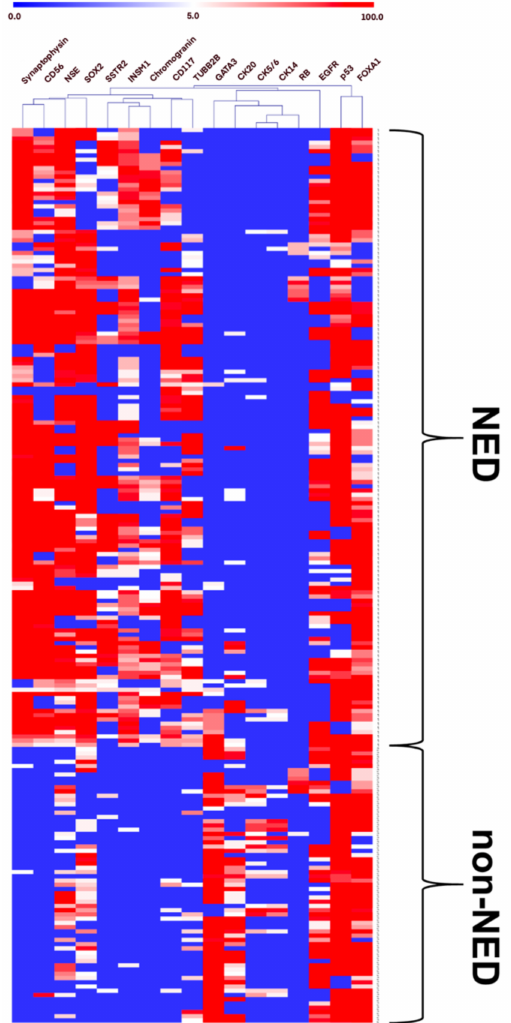
Figure 3. Distribution of the expression of 17 markers in NED and non-NED cores. Heatmap of 17 markers is presented. The white to red shades show increasing immunoreactivity from 5% to 100%, and the blue color represents less than 5% immunoreactivity of IHC markers including no expression. See color